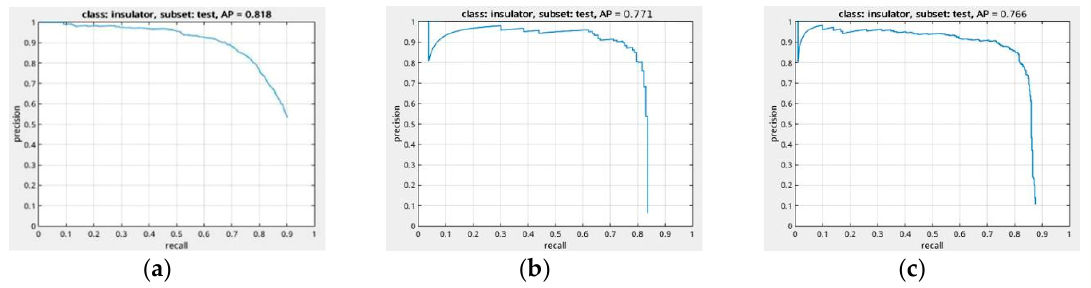
Figure 13. Result comparison of the proposed method, and the R-FCN and SSD methods. ( a ) Proposed method; ( b ) R-FCN; ( c ) SSD.